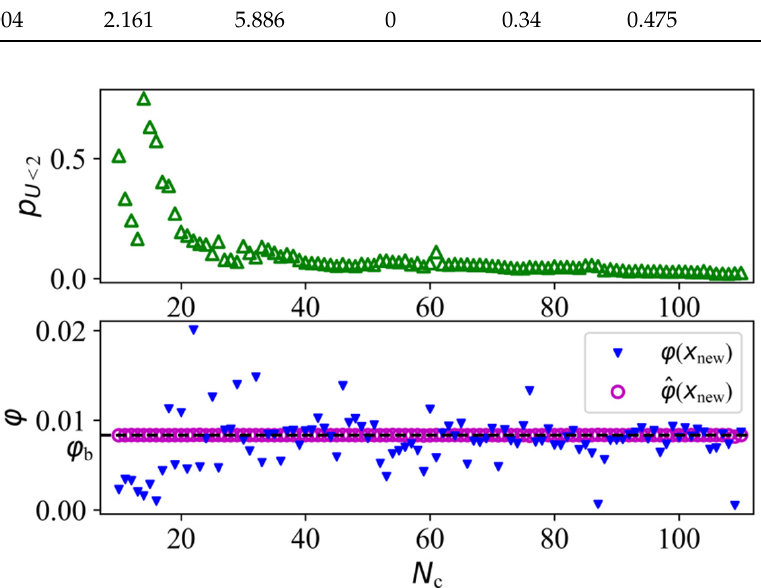
Figure 10. The response of the added samples in Example 2.